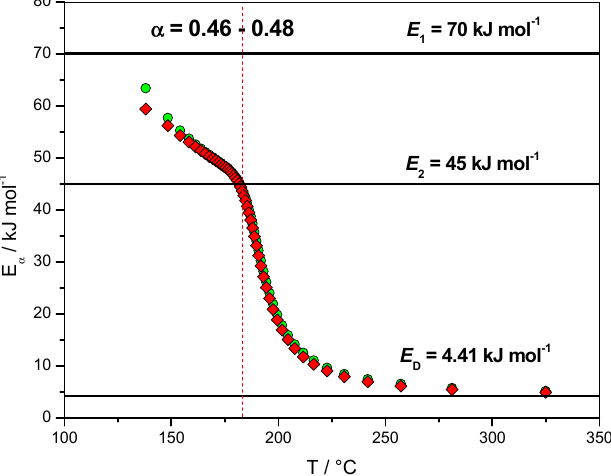
Figure 5. Non-isothermal data. Dependence of the effective activation energy ( E α ) with temperature. Red solid lozenges: E α computed with FR method, green open circles: E α computed with NLN method.